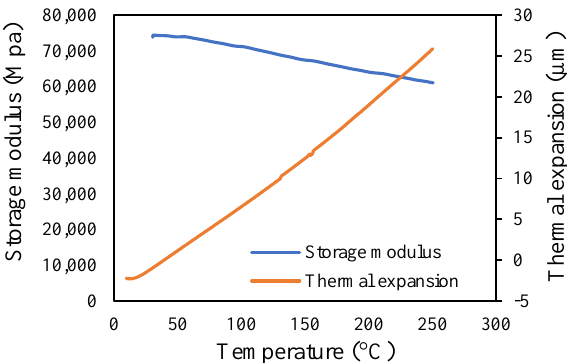
Figure 27. Thermal properties at different temperatures.